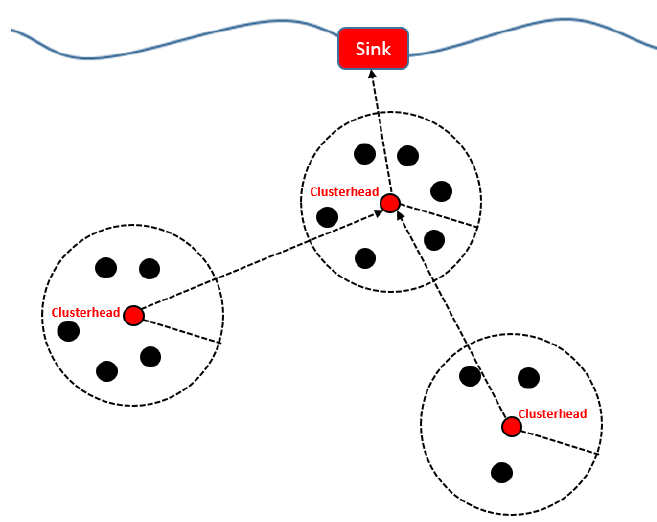
Figure 9. Network Model.